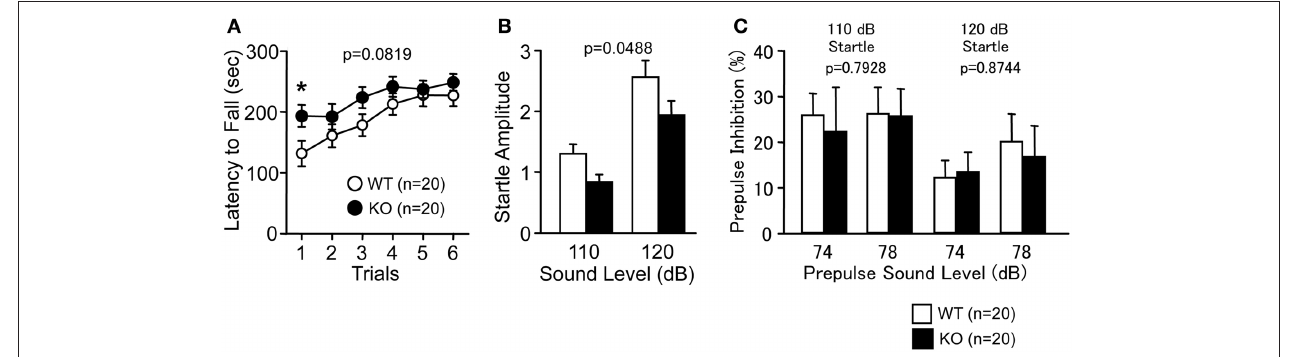
FIGURE 1 | Motor coordination and startle response/prepulse inhibition in PACAP KO mice and wild-type mice. (A) Latency to fall from the rotating drum was shown in the rotarod test. Acoustic startle response (B) and